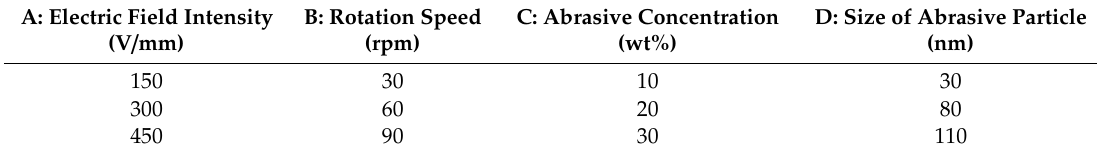
Table 1. Factors and levels of DEPP process